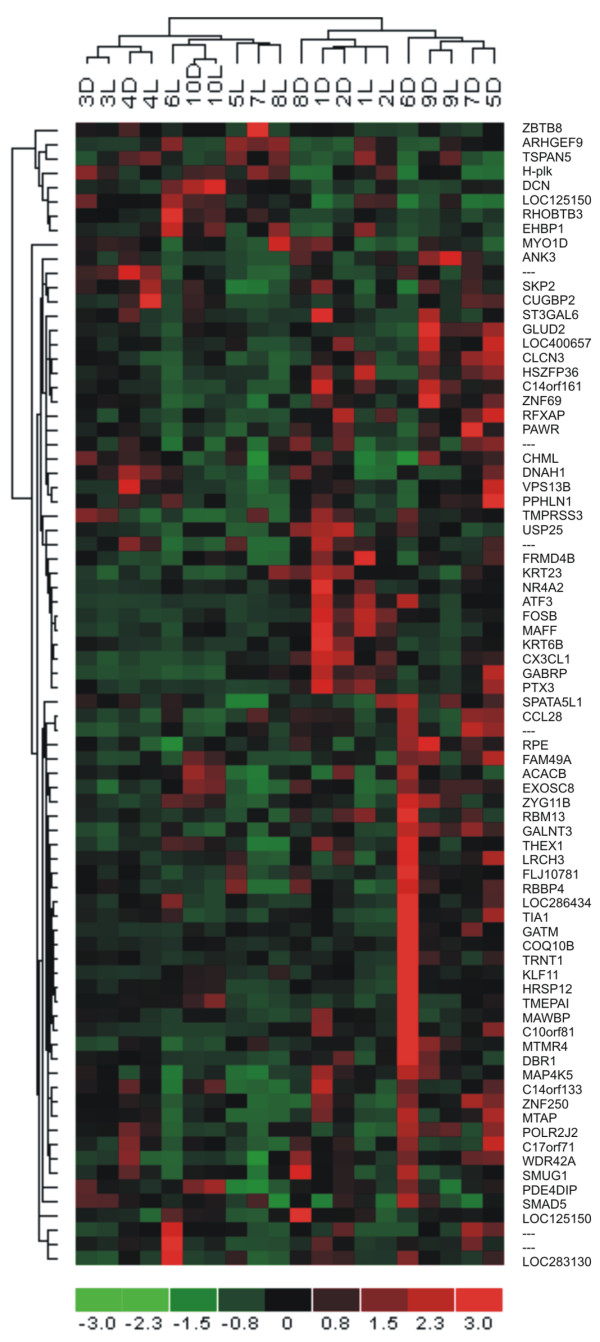
Hierarchical clustering of normal ductal and lobular cells based on 82 probe sets found by both rank products and pairwise analysis. Ductal and lobular cells from the same patients tend to cluster together, and they can not be well separated from each other. This suggests expected similarities of expression signatures in normal epithelial (ductal and lobular) cells of mammary gland tree. 1–10, case numbers; D, ductal normal cells; L, lobular normal cells.